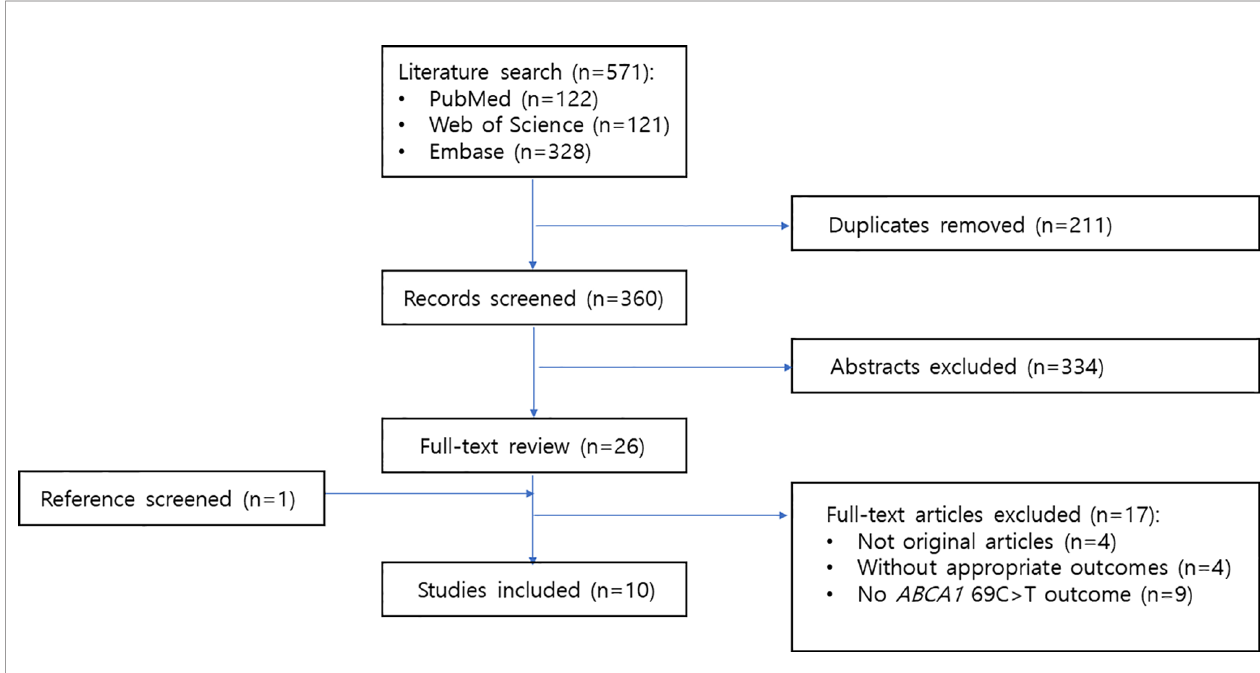
FIGURE 1 | Flow diagram of included